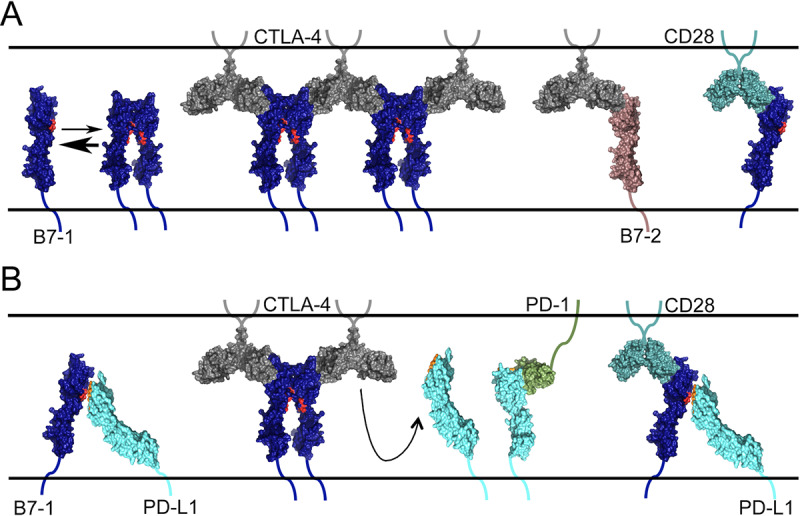
Proposed model for the regulation of the cis bound PD-L1:B7-1 complex.A) B7-1 exists in a monomer-dimer equilibrium. Binding of CTLA-4 cross-links cell surface B7-1 thereby promoting and/or stabilizing B7-1 dimer formation. B7-2 does not dimerize and CD28 may not cross-link B7-1 to the same extent as CTLA-4. B) B7-1 and PD-L1 interact in cis and engagement of CTLA-4 with B7-1 inhibits PD-L1 binding, freeing it to bind PD-1. A tertiary complex may form between CD28, B7-1 and PD-L1 but has not been observed directly. The crystal structures used in the generation of this model cartoon include: 1DR9, 1I8L, 4R0l, 1I85, 4Z18 and 3SBW.